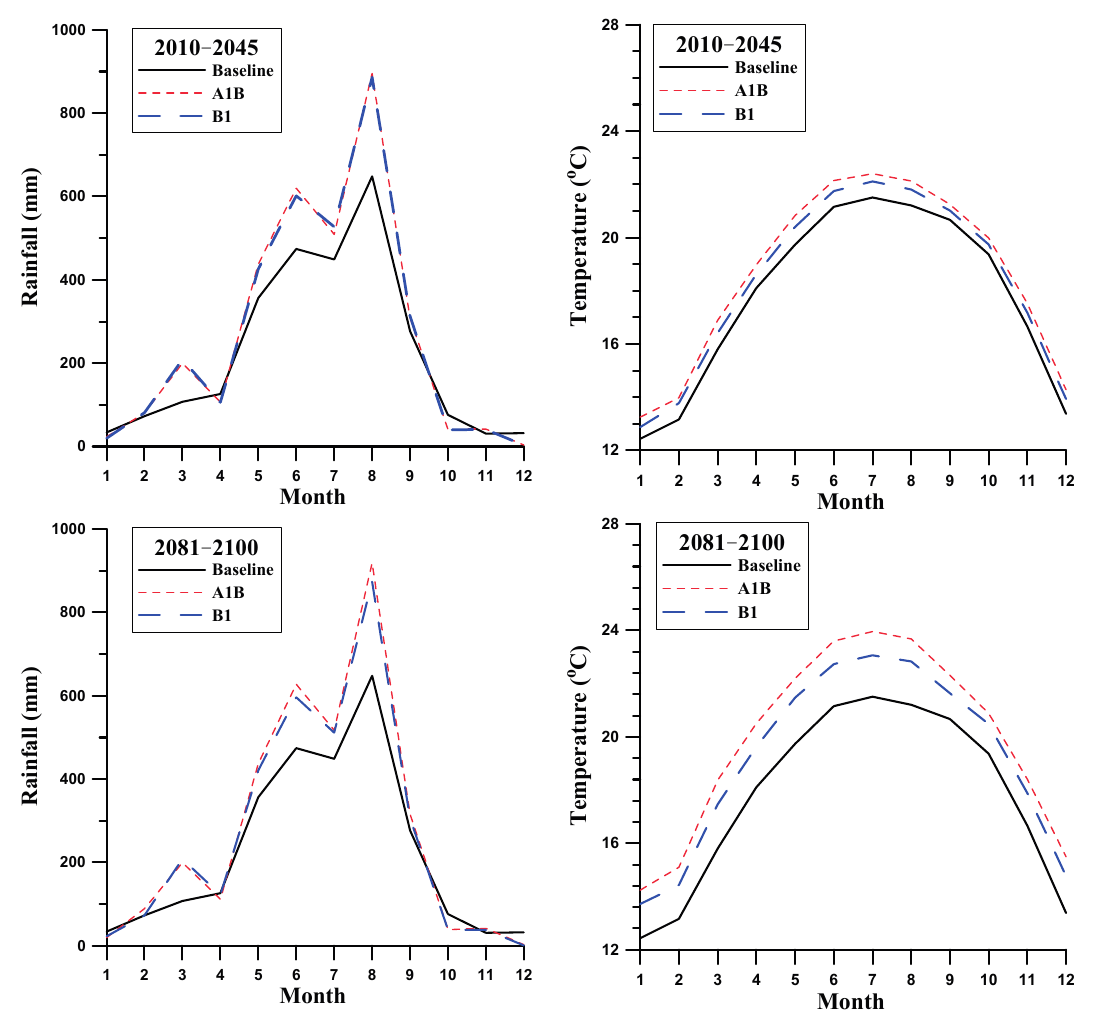
Figure 4. Projected monthly rainfall and mean temperature under A1B and B1 scenarios during the periods of 2010–2045 and 2081–2100,